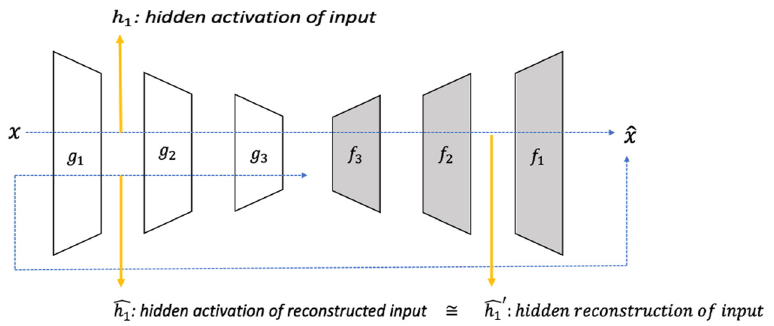
Figure 3. The reconstruction along projection pathway (RaPP) method. The hidden activation of the reconstructed input ˆ h i is equivalent to the hidden reconstruction of the input ˆ h (cid:48) . Comparing the hidden activation of input h i with the hidden activation of the reconstructed input ˆ h i can improve novelty detection.